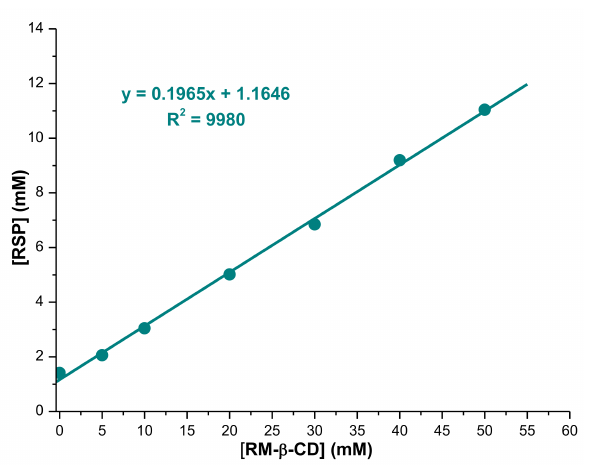
Figure 2. Phase solubility diagram of risperidone (RSP) in the presence of randomly methylated β -cyclodextrin (RM- β -CD) in phosphate buffer 0.1 M, pH 7.4, at 25 ◦